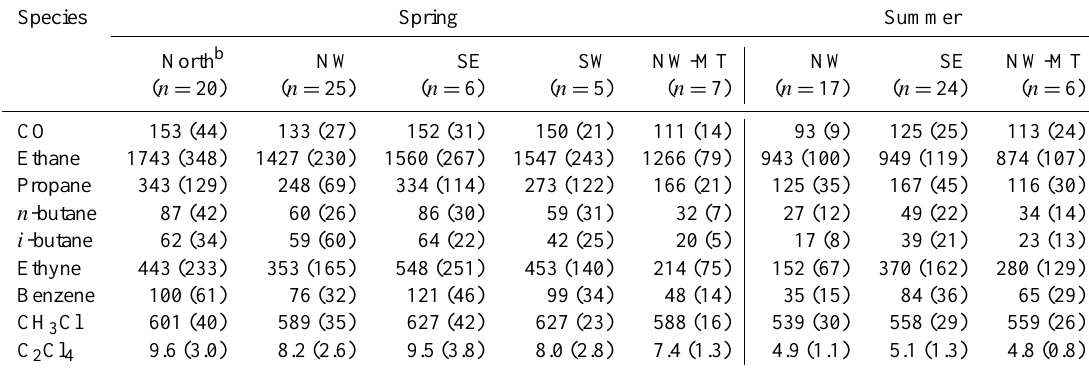
Table 3. Classification results of CO and selected long-lived VOCs in different air mass groups at WLG a . Species Spring Summer North b